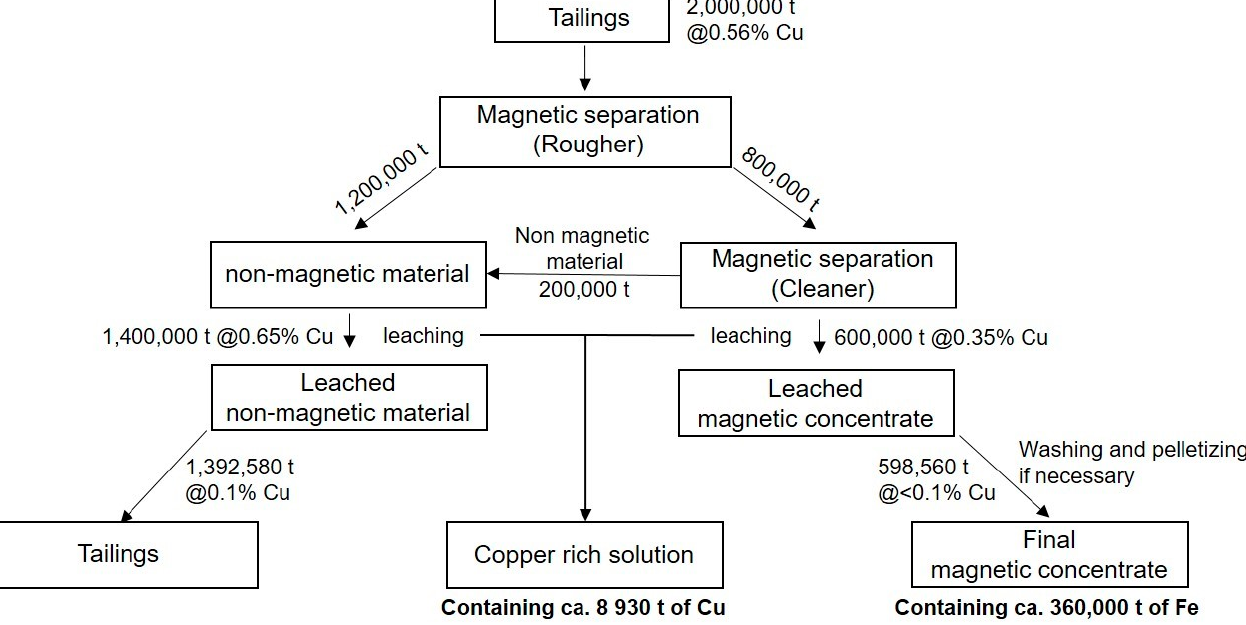
Figure 10. Mass balance for the processing scheme of magnetic separation followed by separate leaching of the magnetic (FM) and non-magnetic fractions